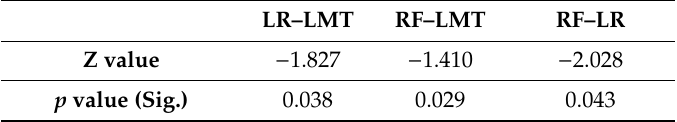
Table 7. Wilcoxon signed rank test for pairwise comparison of prediction accuracy of the